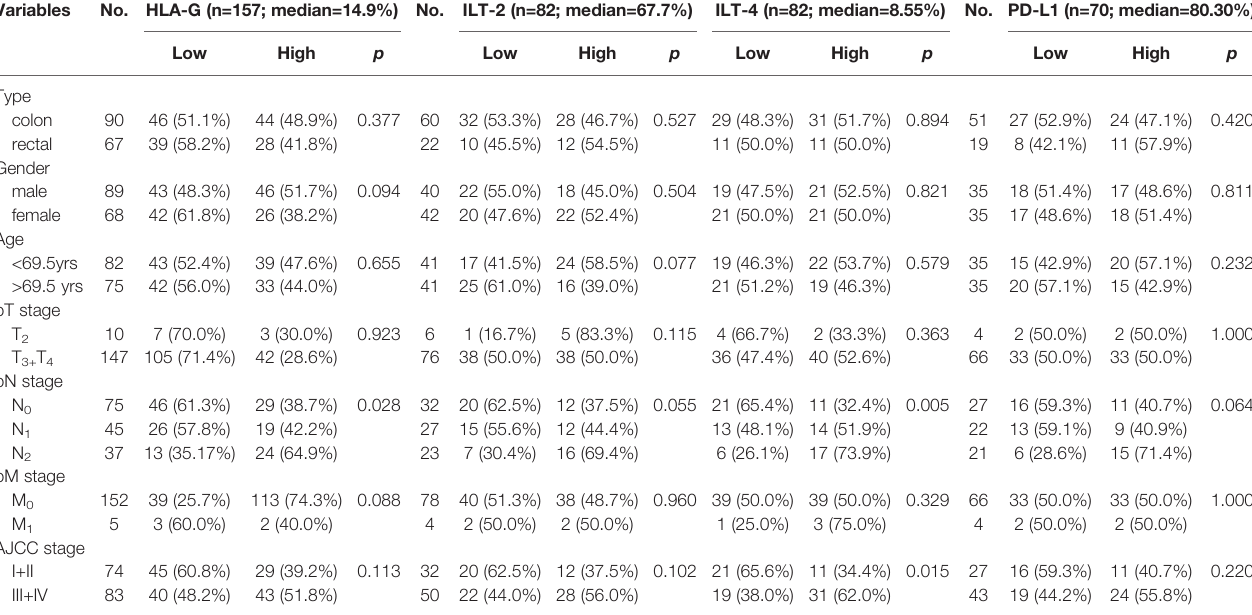
TABLE 1 | Association between high and low levels of immune checkpoint expression with clinical parameters in CRC patients.